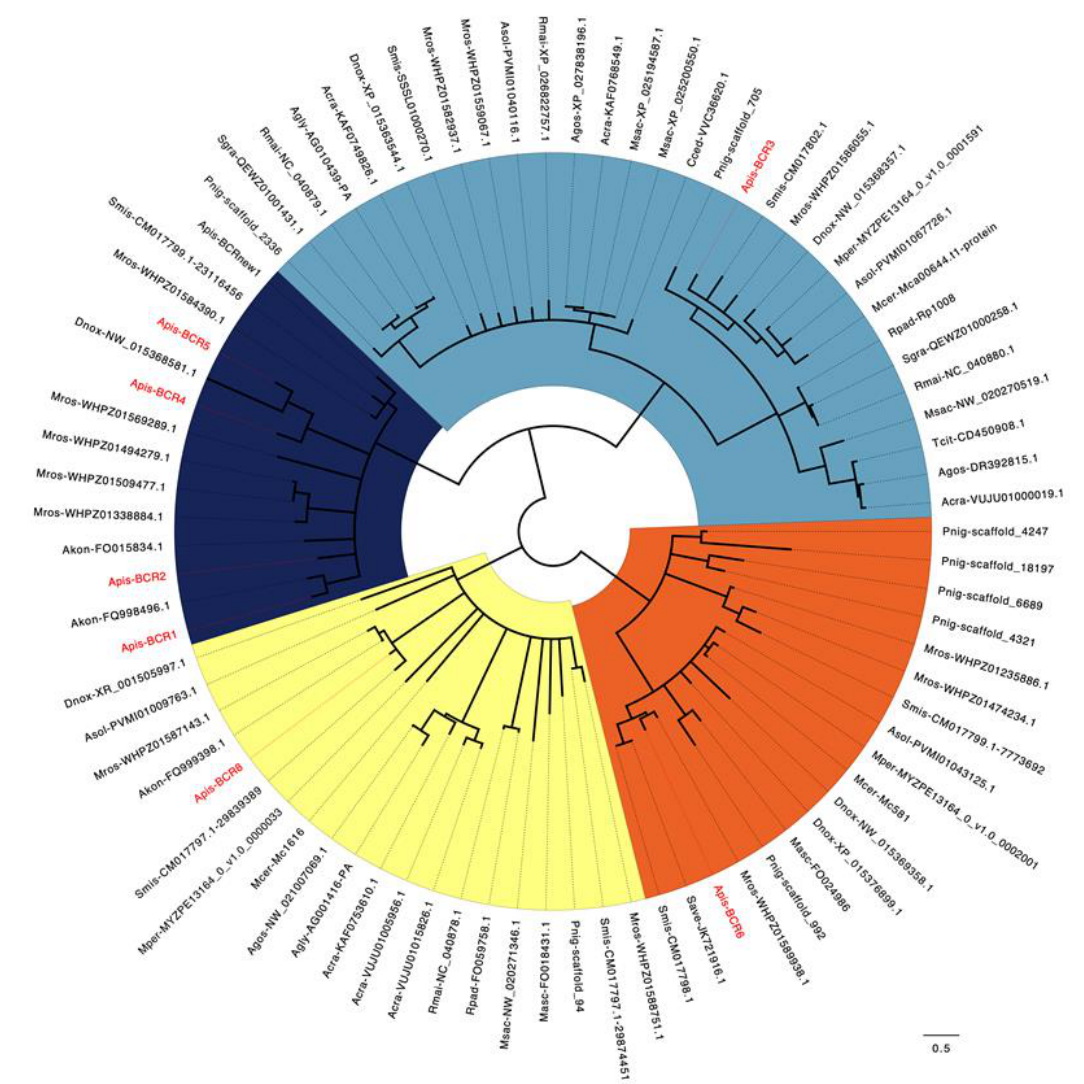
Figure 4. Phylogenetic trees of BCR proteins. Maximum likelihood phylogenetic tree reconstruction was performed using PhyML [37] with an LG 4-rate class model. Branch-support values were calculated using the bootstrap method, with 1000 replicates. Poorly supported branches (<50%) were collapsed using TreeCollapseCL4 [38]. The sequences used for the phylogenetic analysis are listed in Supplementary Materials Table S2. Sequences labeled in red reflect those identified by the Shigenobu and Stern [15] study in the pea aphid ( A. pisum genome V3.0). Abbreviations: Acra, Aphis craccivora ; Agly, Aphis glycines ; Agos, Aphis gossypii ; Akon, Acyrthosiphon kondoi ; Apis, Acyrthosiphon pisum ; Cced, Cinara cedri ; Dnox, Diuraphis noxia ; Dvit. Daktulosphaira vitifoliae ; Masc, Myzus ascalonicus ; Mcer, Myzus cerasi ; Mper, Myzus persicae ; Msac, Melanaphis sacchari ; Rmai, Rhopalosiphum maidis ; Rpad, Rhopalosiphum padi ; Save, Sitobion avenae ; Sgra, Schizaphis graminum ; Tcit, Toxoptera citricida